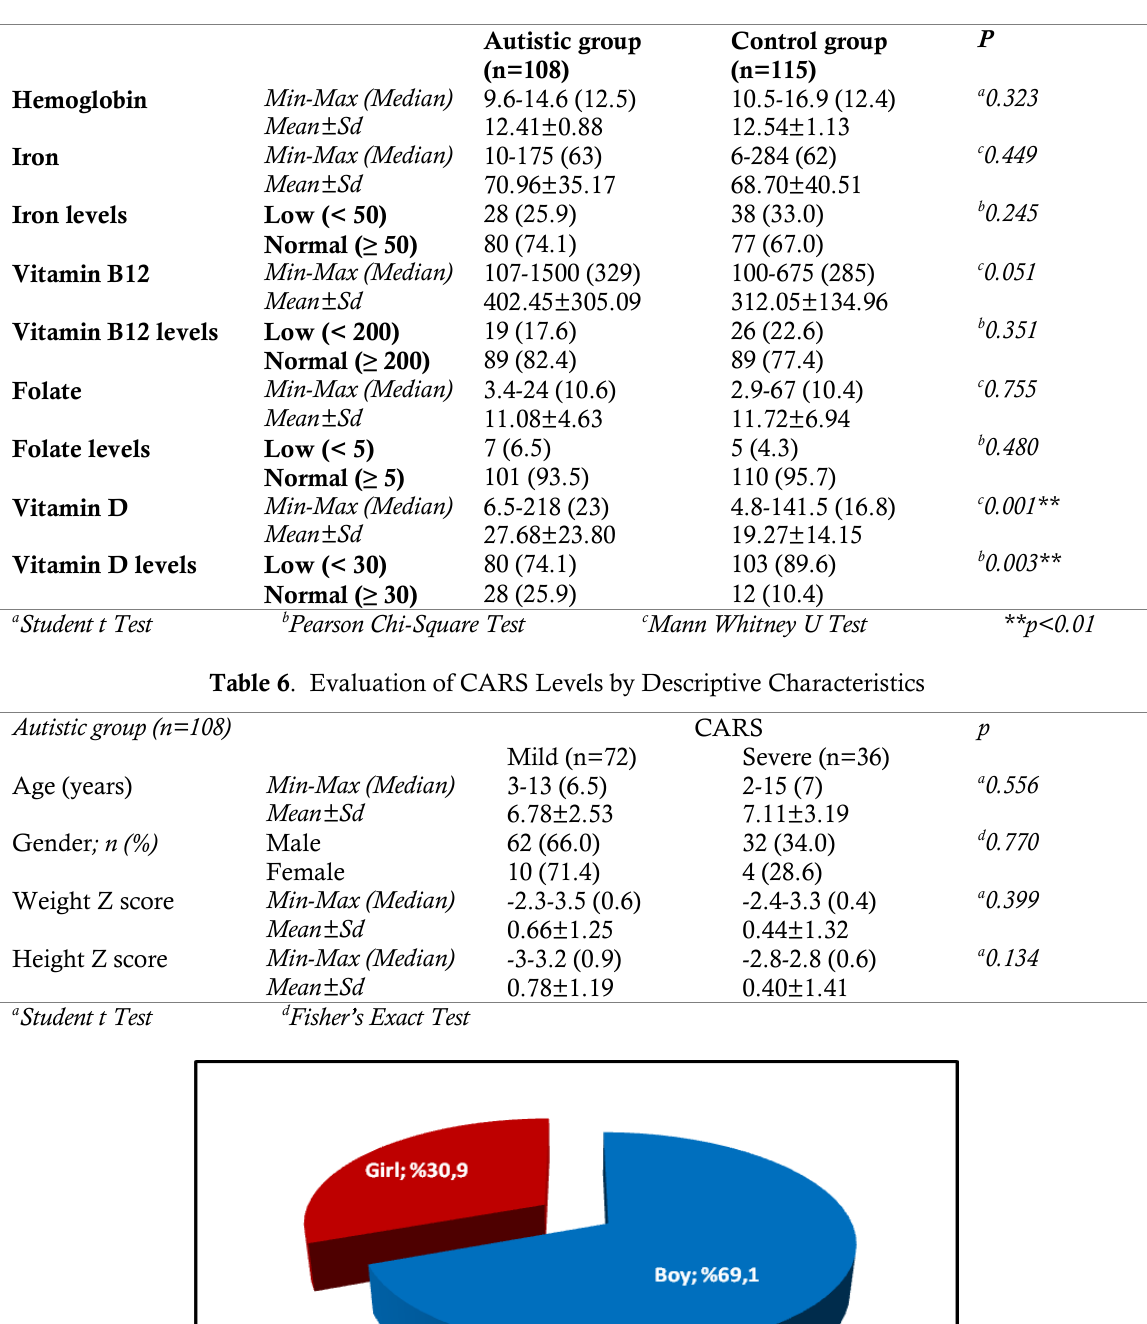
Table 5 . Evaluation of Vitamin and Mineral Measurements by Groups